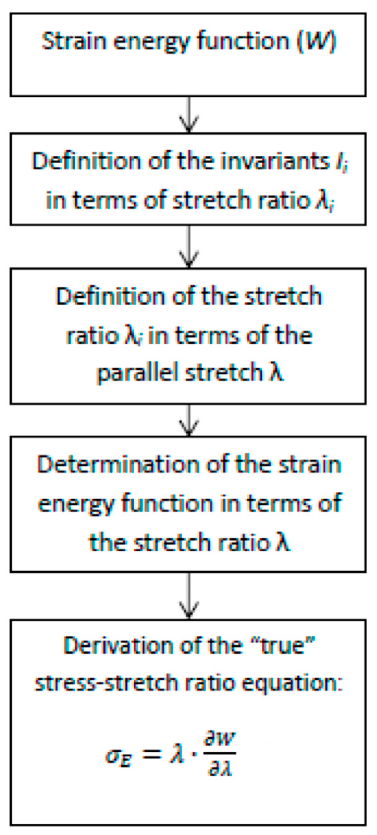
Figure 1. Steps for deriving stress–stretch equation.